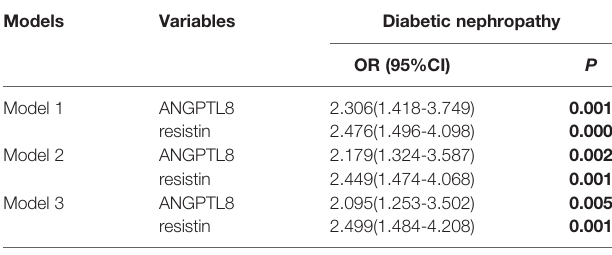
TABLE 3 | Logistic Regression Analysis of ANGPTL8 and resistin for diabetic nephropathy in all patients. Models